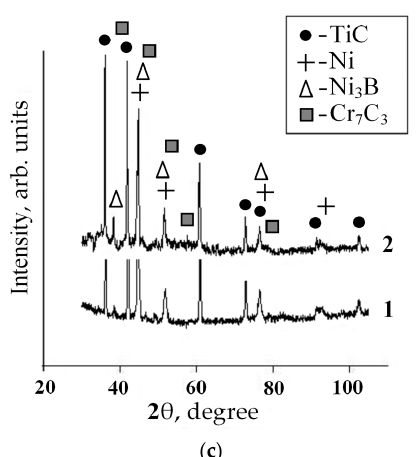
Figure 8. XRD patterns of the SHS-powder materials before (1) and after (2) sintering at 1350 °C: ( a ) TiC-50% high-chromium cast iron binder; ( b ) TiC-50% high-speed steel binder; ( c ) TiC-50% binder of nickel-based self-fluxing alloy. (SHS: Self-propagating high-temperature synthesis).